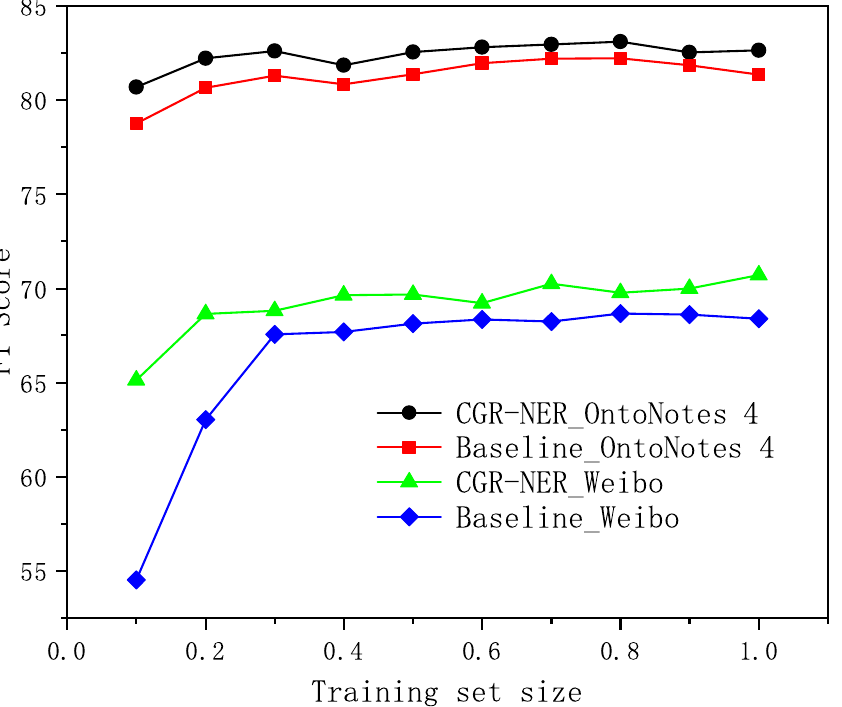
Figure 5. Performance of the model under different training set sizes. The training set size represents the percentage of training samples used in the original training